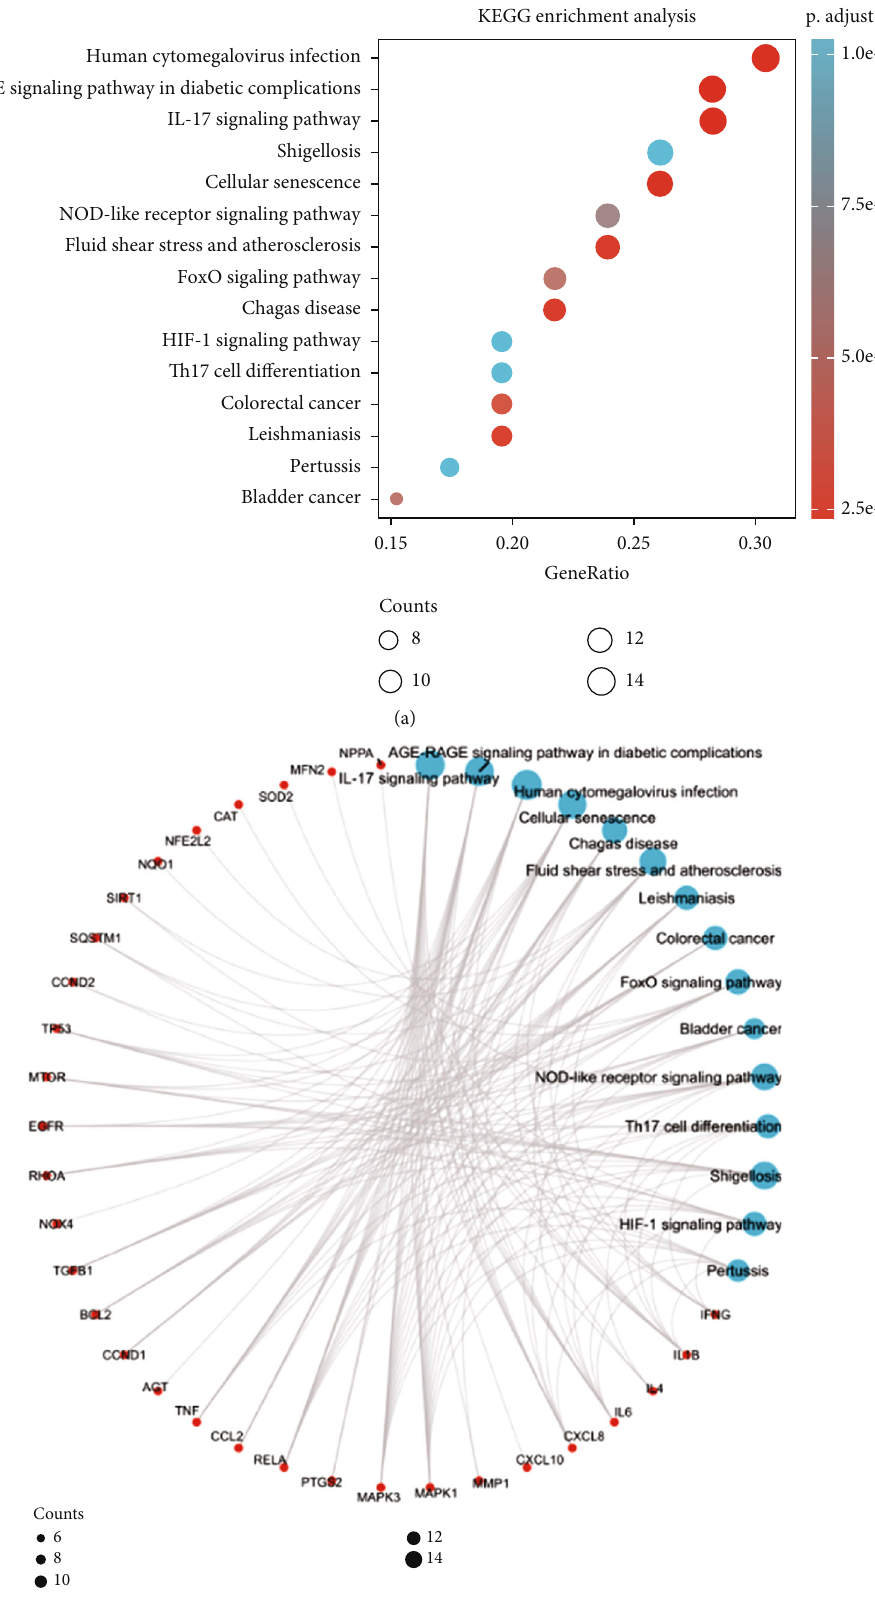
Figure 3: KEGG enrichment analysis of 46 intersection targets. The results of KEGG were presented by bubble (a) and circle (b)